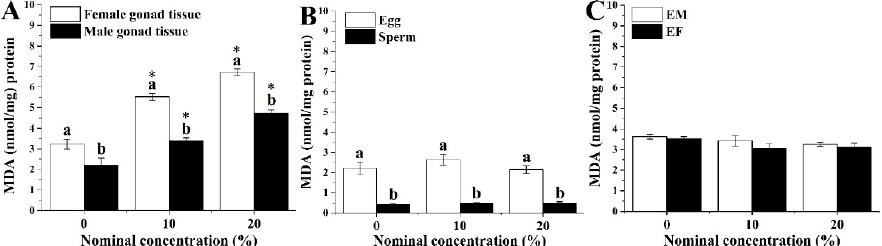
Figure 4. Change of lipid peroxidation (LPO) in ( A ) gonad tissues, ( B ) gametes and ( C ) larvae derived from different parental exposed behaviors with HFO WAFs for seven days. Data are presented as means ± SD. Lowercase letters indicate significant differences between sexes. An asterisk (*) labeled above bars indicates significant differences between treatments and the control ( p < 0.05).